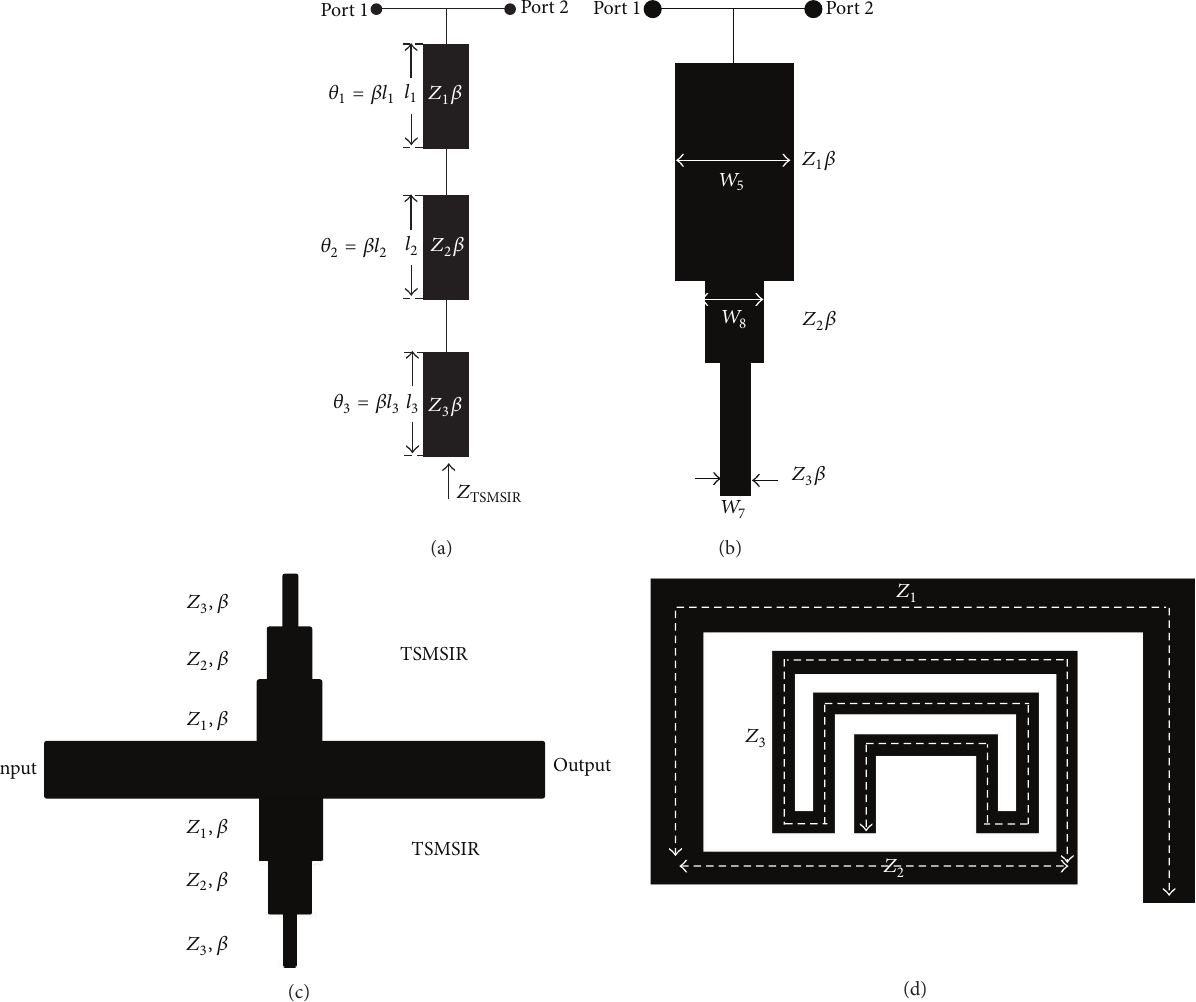
Figure 2: Configuration of (a) the general tri-section SIR, (b) the proposed SIR concept, (c) the proposed concept of a tri-section SIR, and (d) the proposed concept of a